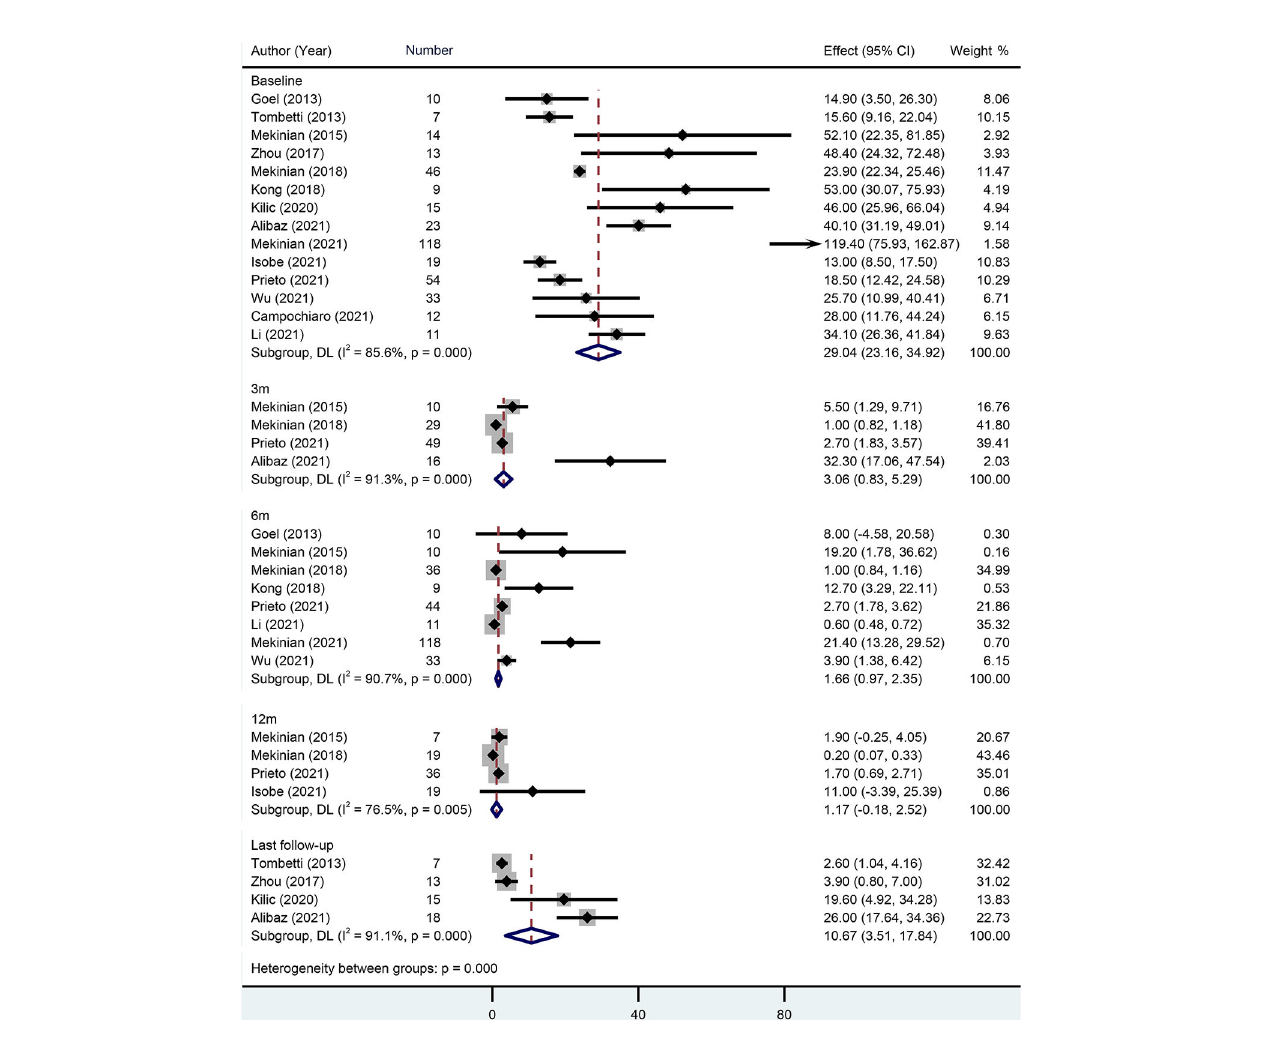
FIGURE 2 Forest plot showing the pooled results of CRP level at the baseline, 3-month, 6-month, 12-month and last